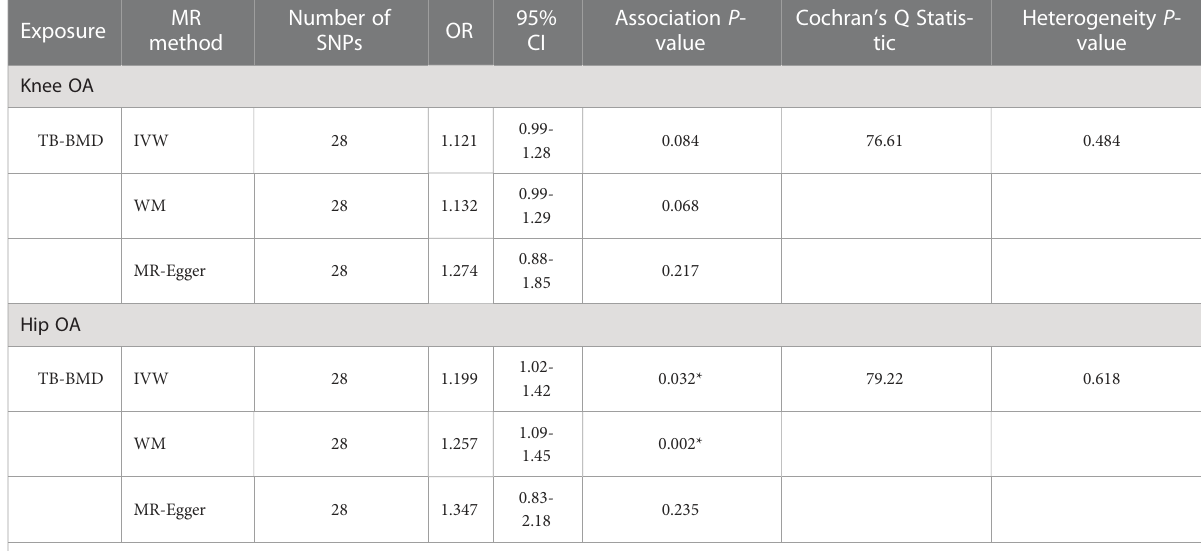
TABLE 3 MR estimates of associations between TB-BMD with knee and hip OA using various analysis methods.